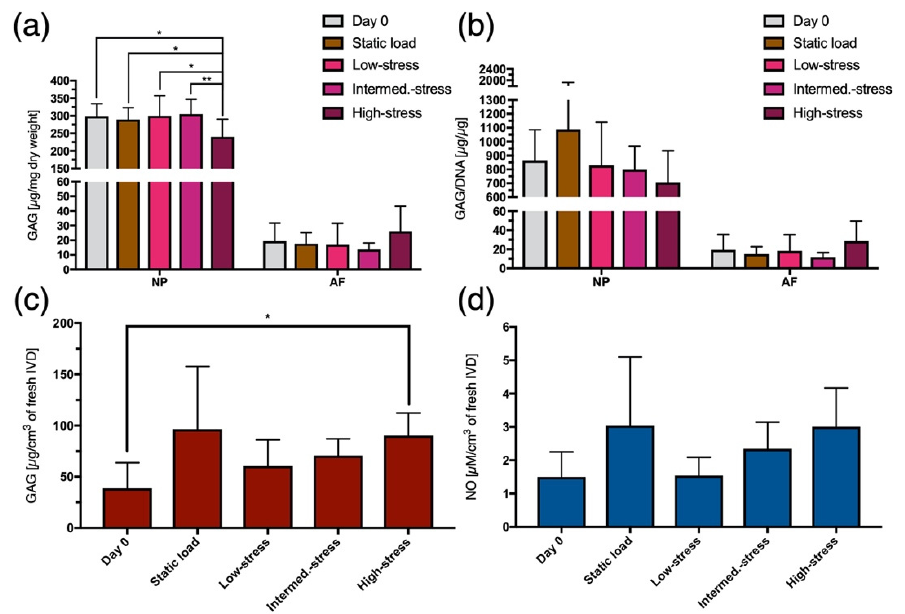
Figure 2. ( a ) GAG content in the nucleus pulposus (NP) and in the annulus fibrosus (AF) relative to their tissue dry weight. ( b ) GAG content in the NP and AF tissue relative to their DNA content. ( c ) Amount of GAG released from the IVDs into the culture medium in relation to the IVDs’ volume after their isolation from a bovine tail. ( d ) Amount of NO released from the IVDs into the culture medium in relation to the IVDs’ volume after their isolation from a bovine tail. Mean ± SD, N = 6–7, p -value: * <0.05, ** <0.01.